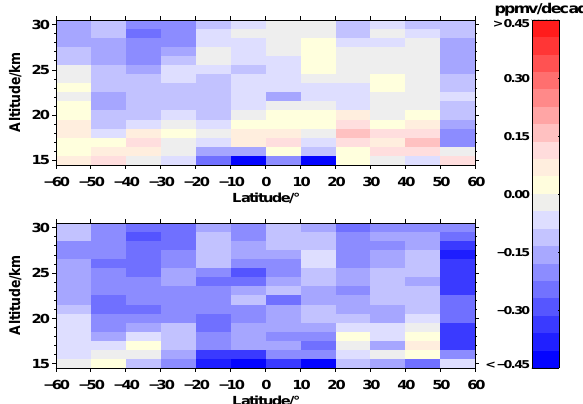
Figure 11. Linear terms of the multivariate regression of water vapour time series with and without the inclusion of a solar term in the regression model. Top panel: standard approach without solar term; lower panel: including F10.7